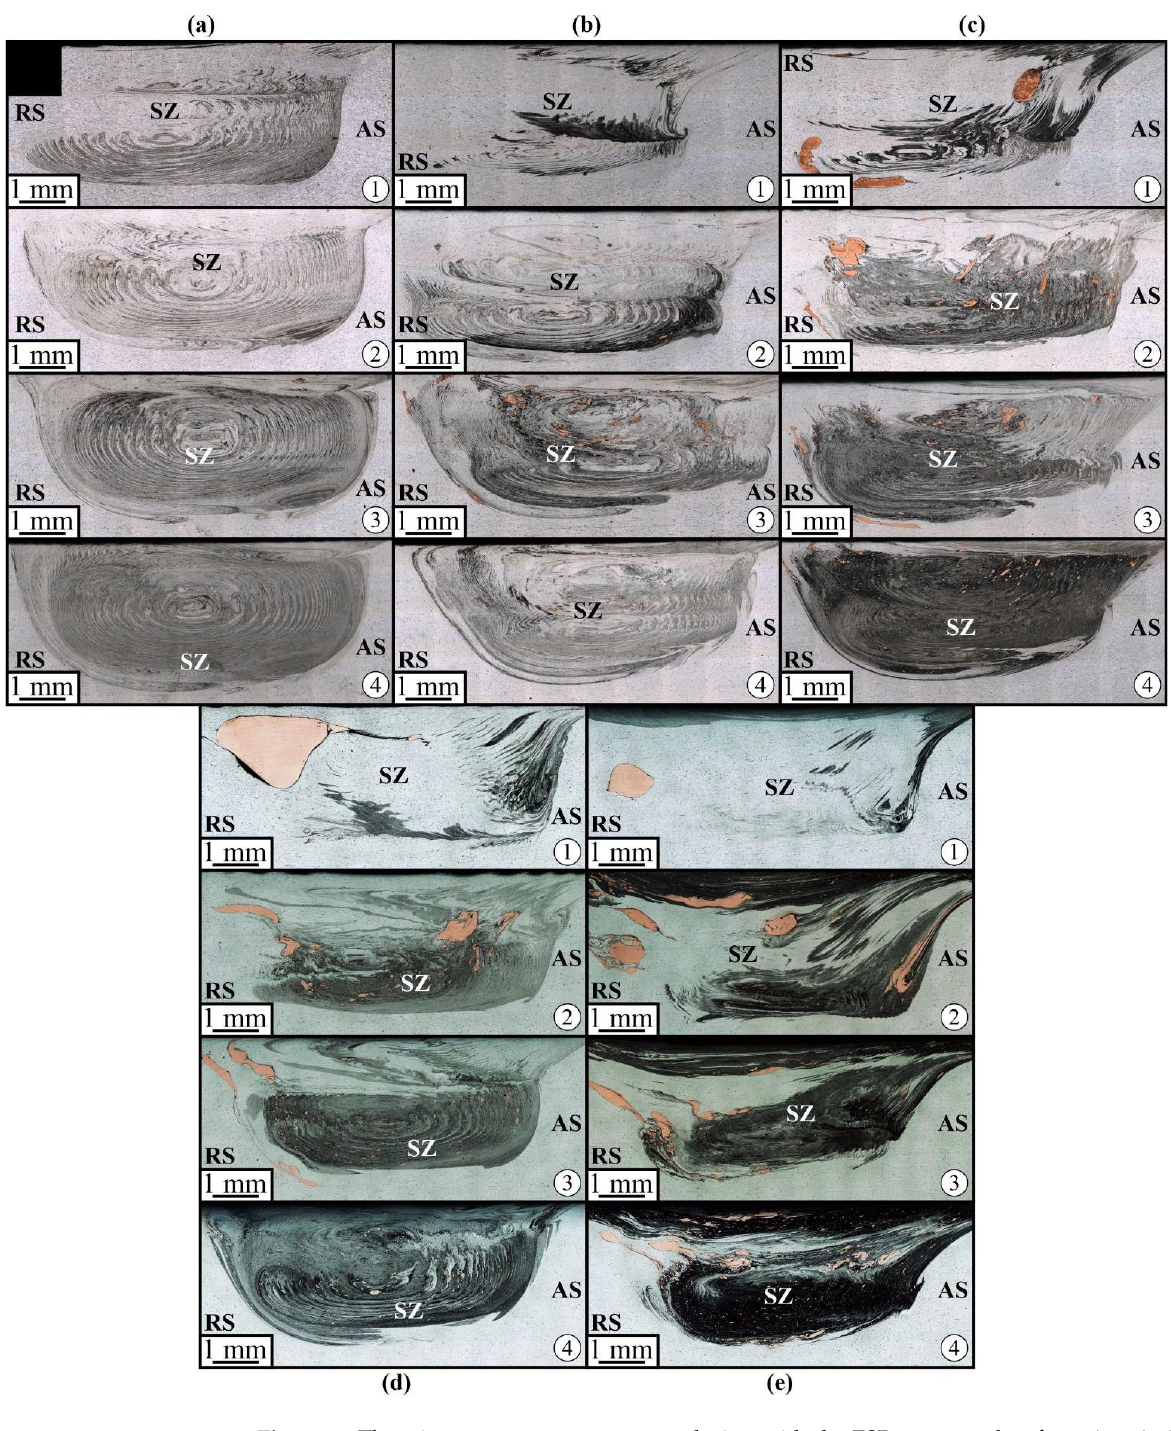
Figure 4. The stir zone macrostructure evolution with the FSP pass number from 1 to 4 views in samples containing 1.5% ( a ), 3% ( b ), 6% ( c ), 15% ( d ) and 30% ( e )